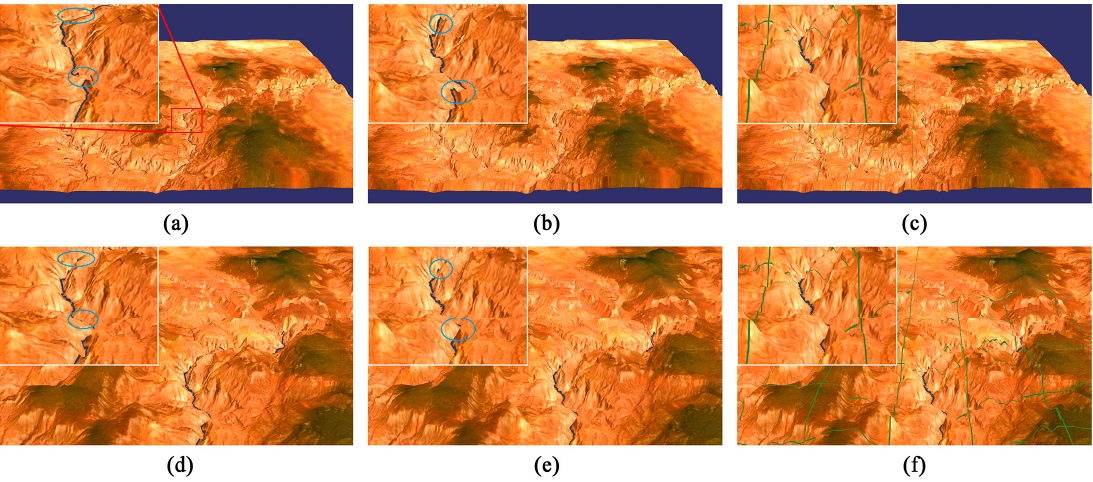
Figure 16. Visual effect comparison in Area II: ( a ) and ( d ) for Method I. ( b ) and ( e ) for Method II. ( c ) and ( f ) for our method.